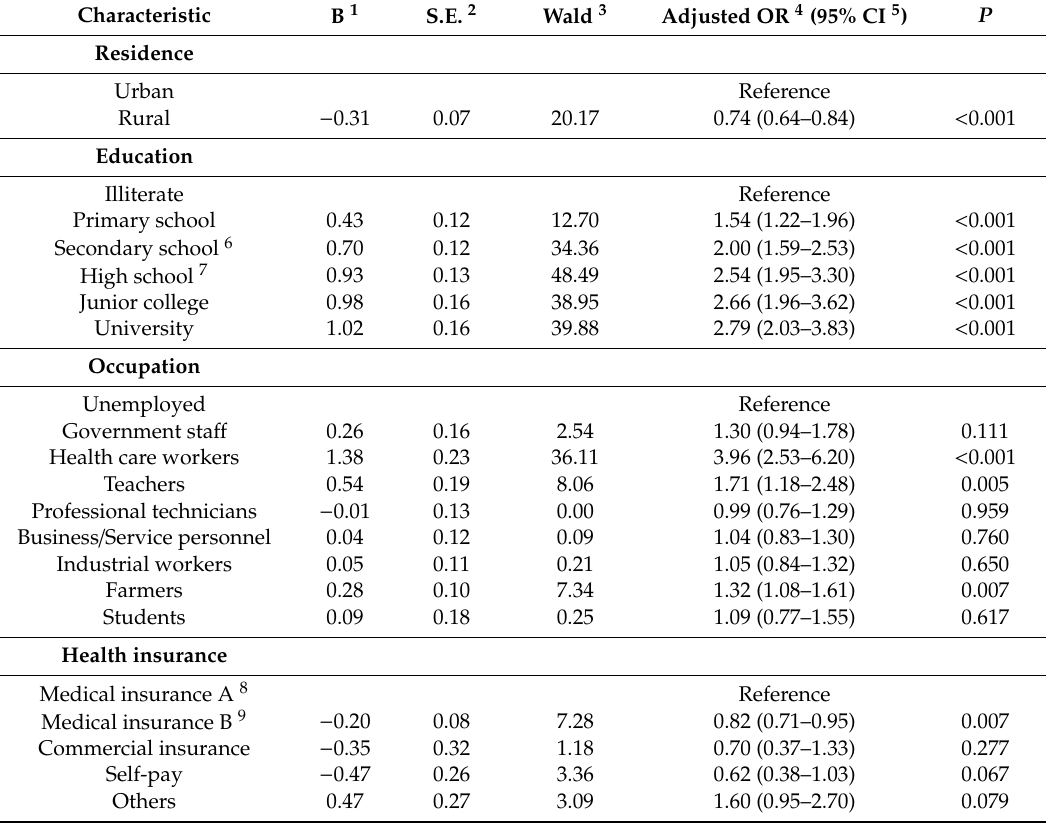
Table 6. Multivariate analysis of associated factors on the level of awareness of the five pieces of key information about TB among respondents with di ff erent characteristics in Zhejiang Province,